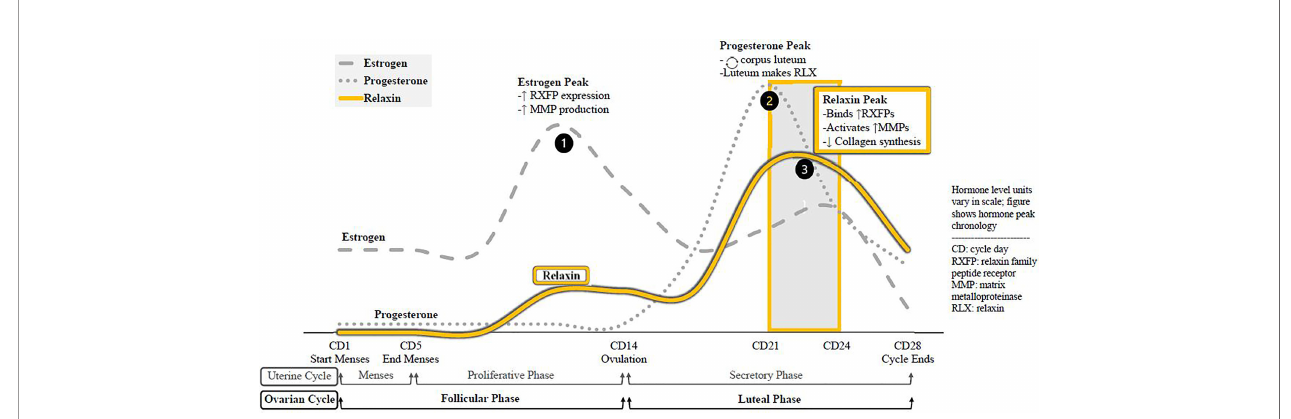
FIGURE 1 | Menstrual cycle hormone peaks, molecular effects. The sequence of hormone peaks for ovulatory cycles. Estrogen levels peak fi rst, increasing expression of relaxin receptors in the body and increasing global synthesis of MMPs. The drop in estrogen triggers ovulation, and the remains of that ovarian follicle from the corpus luteum. As a temporary endocrine body, the corpus luteum secretes progesterone to prepare the endometrium for pregnancy and to sustain itself. It also synthesizes and relaxin, which binds receptors and activates. MMPs recently upregulated by estrogen while suppressing de novo collagen synthesis. Relaxin is active during the luteal phase, chie fl y CD21-24.